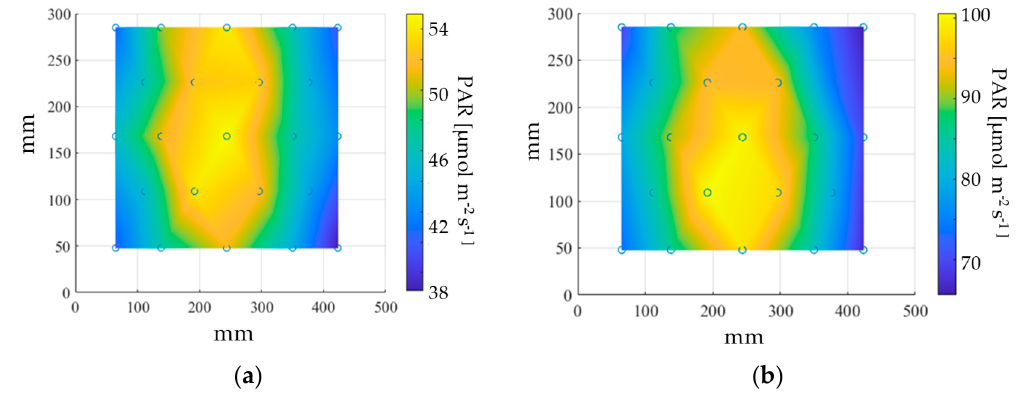
Figure 2. Spatial distribution of the photosynthetically active radiation (PAR, µmol m − 2 s − 1 ) on the modulable spectrum plant experimental chamber inner surface for a 5- ( a ) and 10-LEDs ( b ) luminaires. Blue circular shapes indicate the coordinates from which measurements were taken.